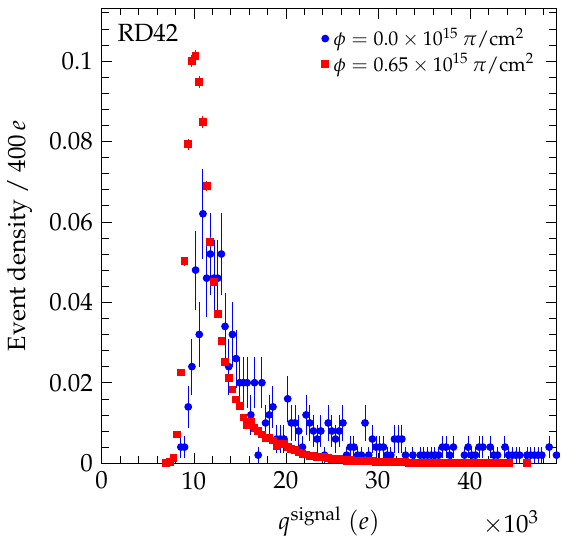
Figure 4. The signal charge spectrum evolution for the scCVD diamond sample irradiated with 200MeV pions biased at E = + 2V/µm. The pulse height spectrum before irradiation was measured using a setup with a 90 Sr β -source and a single pad metallization on the diamond, biased at 1V/µm, since the detector collects all the charge at a bias voltage of 200V. The integral of each spectrum was normalized to